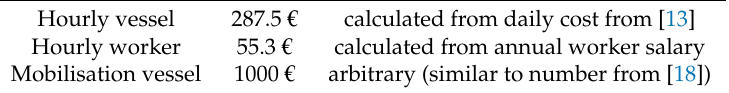
Table 5. Input used to calculate the maintenance